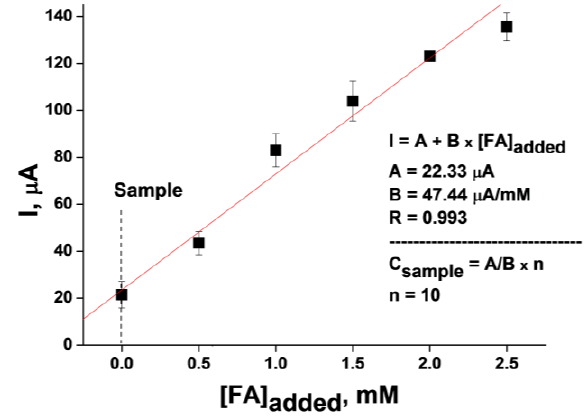
Figure 4. Amperometric determination of formaldehyde in a wastewater sample using a 4 mm planar Pt-gold electrode DRP-C220AT. Conditions: working potential 0 mV